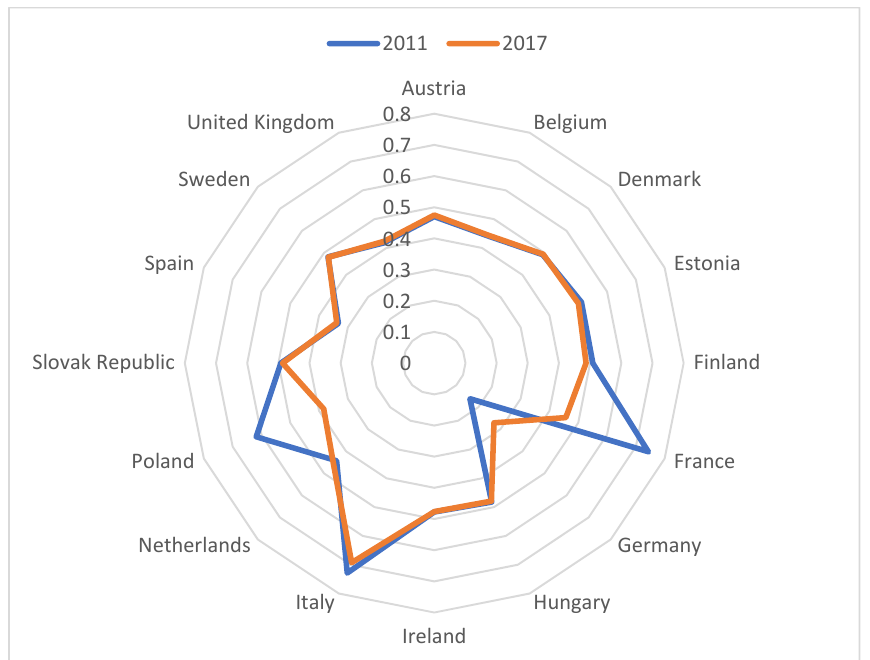
Figure 4. The average level of environmental performance of fossil fuels R&D (million USD and PPP) for selected EU countries in 2011 and 2017.